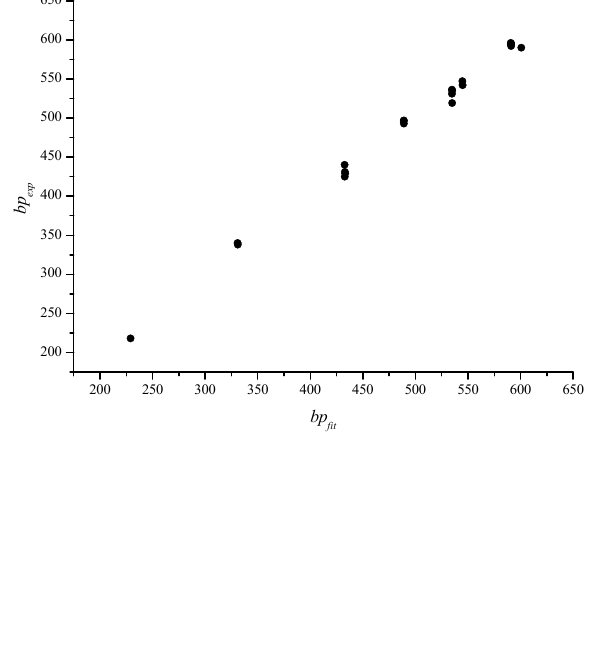
Figure 7. Scatter plots between the experimental ( bp ) and cross-validated ( bp fit ( bp fit